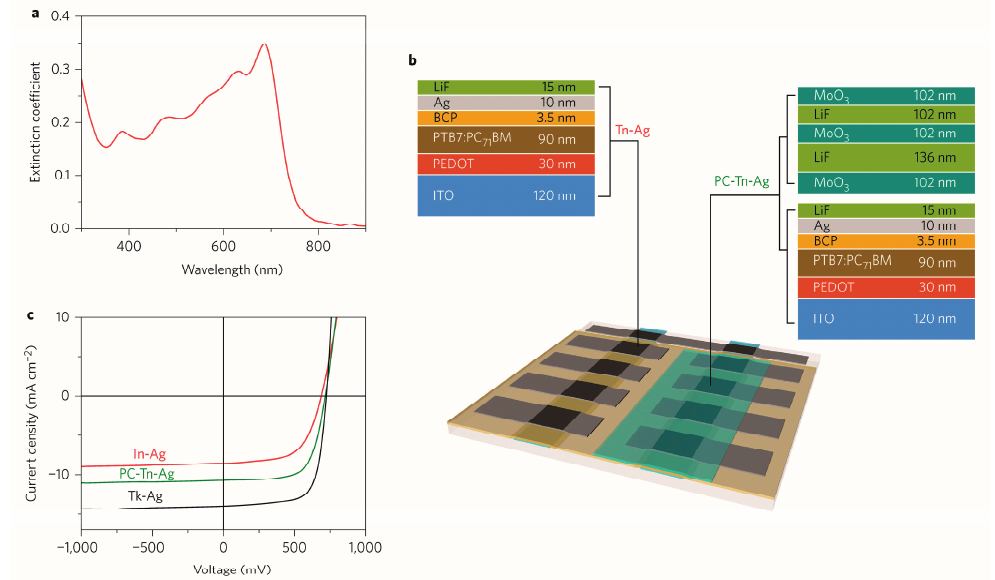
Figure 11. Polymer blend and device: ( a ) polythieno(3,4-b)-thiophene- co -benzodithiophene BM) extinction coefficient; (PTB7):(6,6)-phenyl-C71-butyric acid methyl ester (PC 70 ( b ) Schematic view of the fabricated photovoltaic cells. Two stripes of ITO were crossed by eight stripes of silver layers defining 9 mm 2 cells. The other layers between the electrodes were deposited to cover the entire substrate. A long metal stripe at the back was deposited to contact the ITO. Using a mask, the photonic crystal was grown to cover, as in the schematic, half of the devices. The layer thicknesses given for the photovoltaic part of the structure are the ones used for all semi-transparent devices in the current work. The thicknesses for the photonic-crystal layers correspond to a device for which the current density-voltage curve would be similar to the one shown in ( c ); Layer thicknesses are not fully to scale; ( c ) Current density-voltage curves for the opaque cell (Tk–Ag) (black), semi-transparent cell where top electrode is 10-nm-thick silver layer (Tn–Ag) (red) and the cell incorporating the photonic crystal (PC–Tn–Ag)